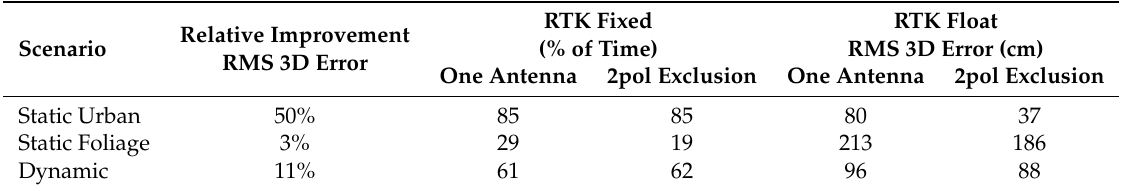
Table 3. Comparison of the results of some parameters for the three considered scenarios: Relative improvement in terms of RMS 3D error, the percentage of time in RTK fixed mode and RMS 3D error in the RTK float mode when applying exclusion or